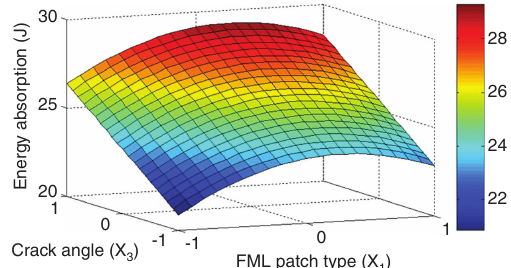
Figure 8 Response surface plot showing the effect of FML patch type ( X ) and crack angle ( X ) on energy absorption values for crack 1 3 length ratio of a / w =